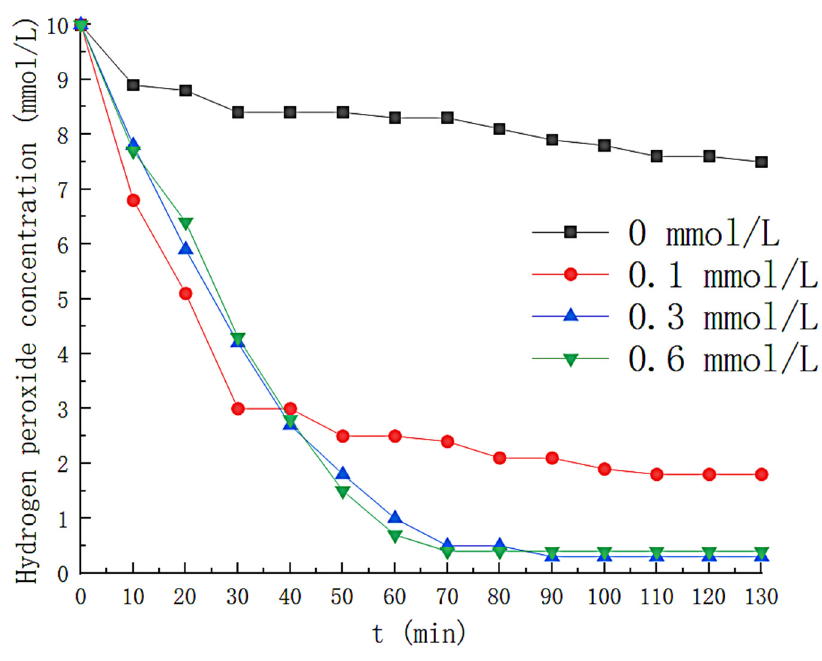
Figure 6. Effect of Fe 2+ concentration on hydrogen peroxide concentration.